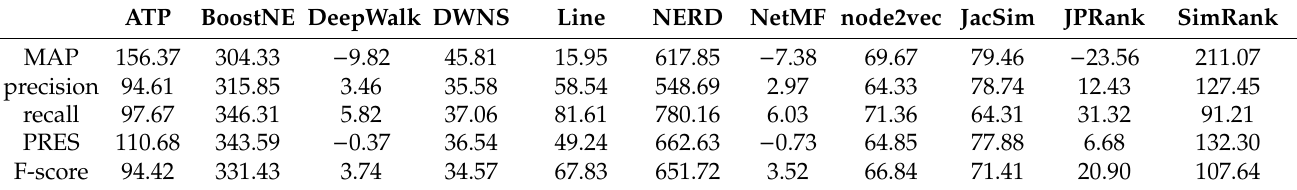
Table 11. Accuracy improvements (%) by SimRank* over other methods with the TREC